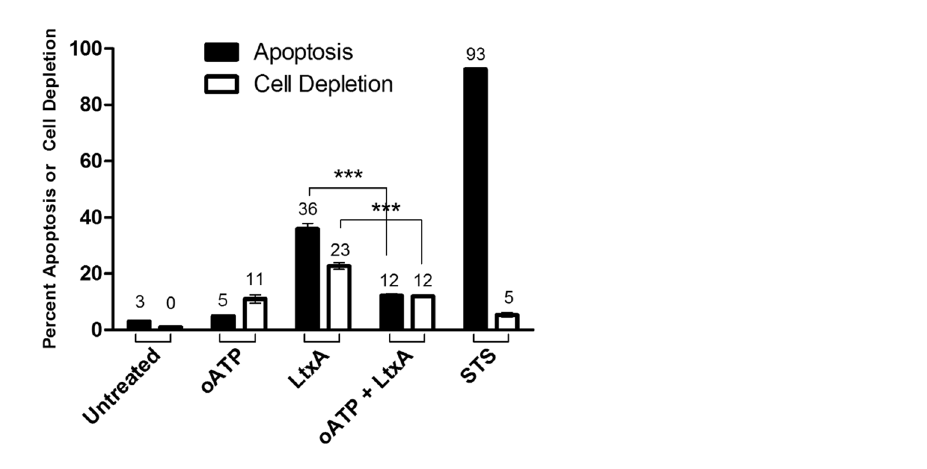
Figure 9. LtxA induces two distinct death pathways in Jurkat cells. Jurkat wild-type cells were treated with LtxA for 3 h with or without oATP. Without oATP, LtxA induces a distinct apoptotic population (Annexin V+) as well as a lytic population (cellular depletion). When Jurkat cells are pre-treated with oATP prior to LtxA treatment, the apoptotic population is decreased and the lytic population is